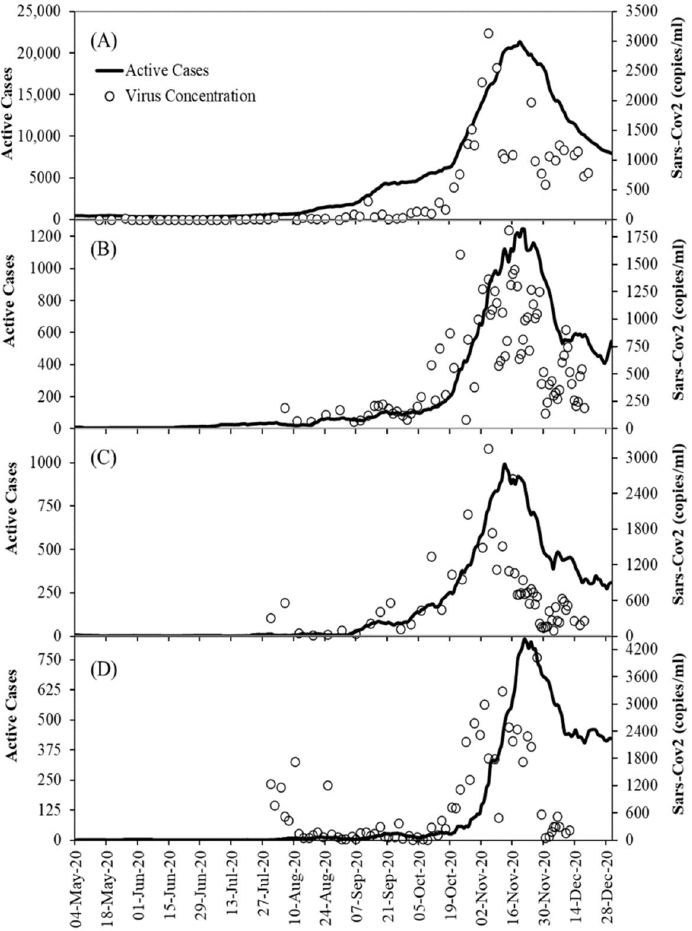
Figure 2. Raw data timeline of SARS-CoV-2 gene copy numbers (copies/mL) and epidemiological timelines at the four sampling sites, where ( A – D ) corresponds to WWTPs A–D.